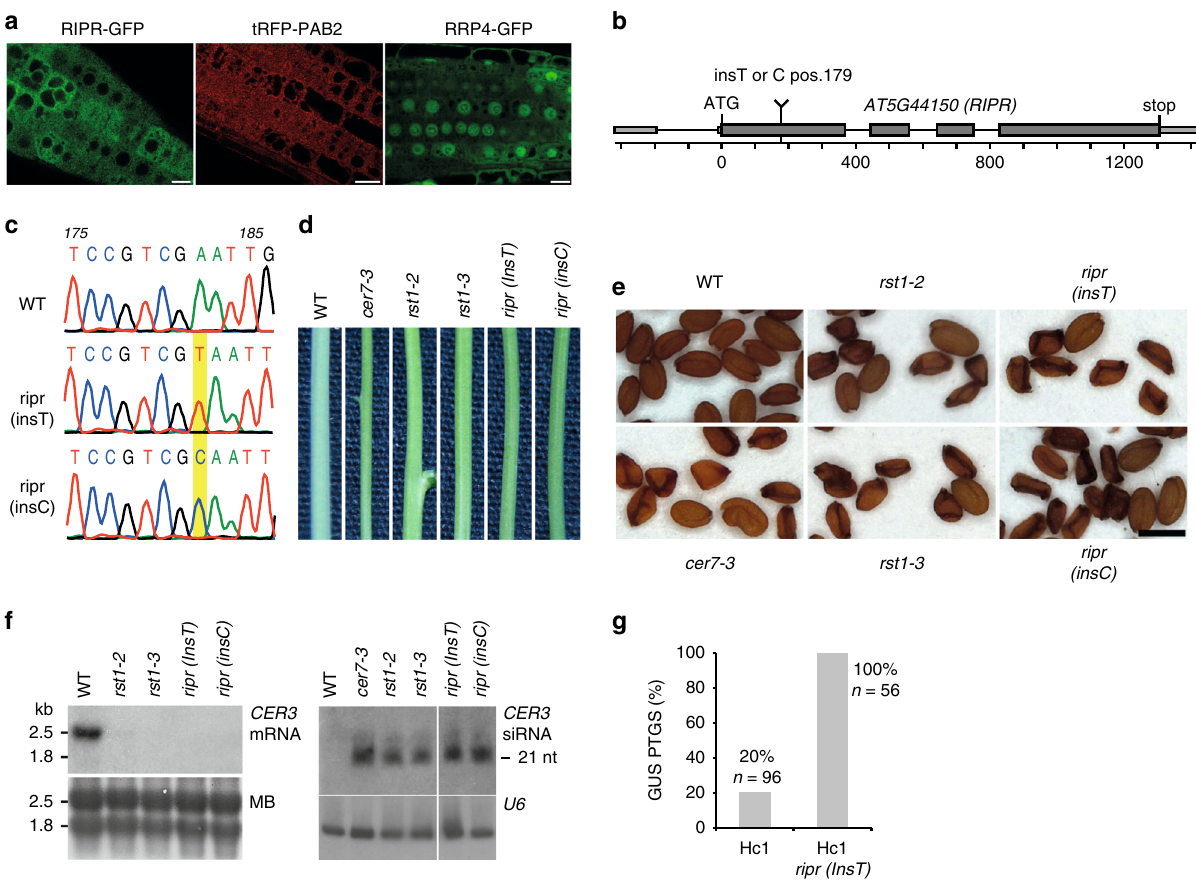
Fig. 7 Loss of RIPR function phenocopies rst1 mutants. a Confocal microscopy of plants expressing RIPR-GFP, the cytosolic marker tRFP-PAB2 and a GFP- tagged version of the exosome subunit RRP4. Scale bars are 20 µ m. The source data are available at [https://doi.org/10.6084/m9. fi gshare.c.4483406]. b Scheme of the AT5G44150 gene encoding the RIPR protein. Small and large boxes represent exons in the UTRs and CDS, respectively, lines represent introns. The single insertion of a T or C nucleotide at position 179 (from the ATG) results in a frameshift, which creates a premature stop codon. c Electropherograms of the genomic DNA sequence surrounding the relevant position of the AT5G44150 locus in wild-type, ripr(insT) and ripr(insC) plants. d Stem sections from wild-type (WT), cer7 , rst1 and ripr plants. e cer7-3 , rst1 and ripr mutants produce similar proportions of non-viable seeds. Scale bar is 0.5 mm. Please also see the uncropped pictures provided in Supplementary Fig. 4. f Northern blots showing the downregulation of the CER3 mRNA (left) and the upregulation of CER3 -derived siRNAs (right) in ripr mutants. Loading controls show the methylene blue stained membrane (MB, left) and the hybridisation with a probe speci fi c to U6 snRNA (right). The uncropped blots can be seen in Supplementary Fig. 5, and are also available at